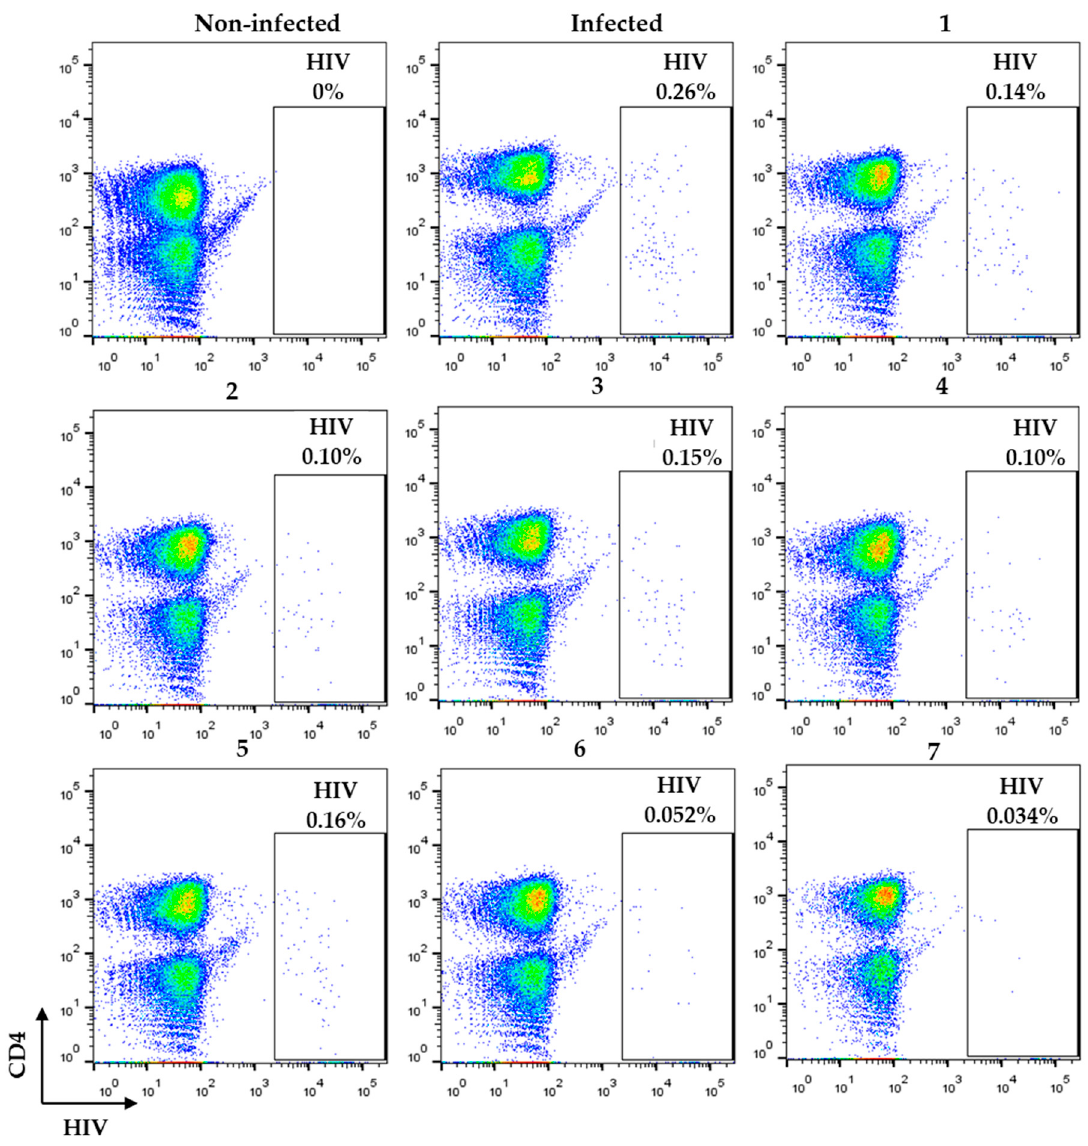
Figure 5. Frequency of HIV-1 infected primary CD4 + T cells treated with AZT-derivatives before infection. Dot plots illustrating primary T cells HIV-1 infection levels in primary CD4 + T cells either left untreated (infected) or treated post with AZT-derivatives (Infected+ compound).